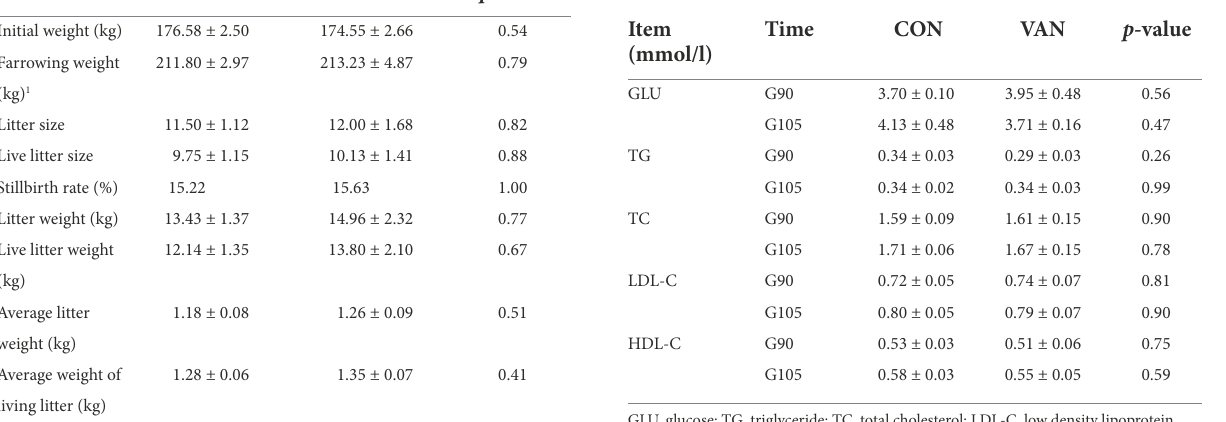
TABLE 2 Effects of vancomycin on blood biochemical indexes of sows during late